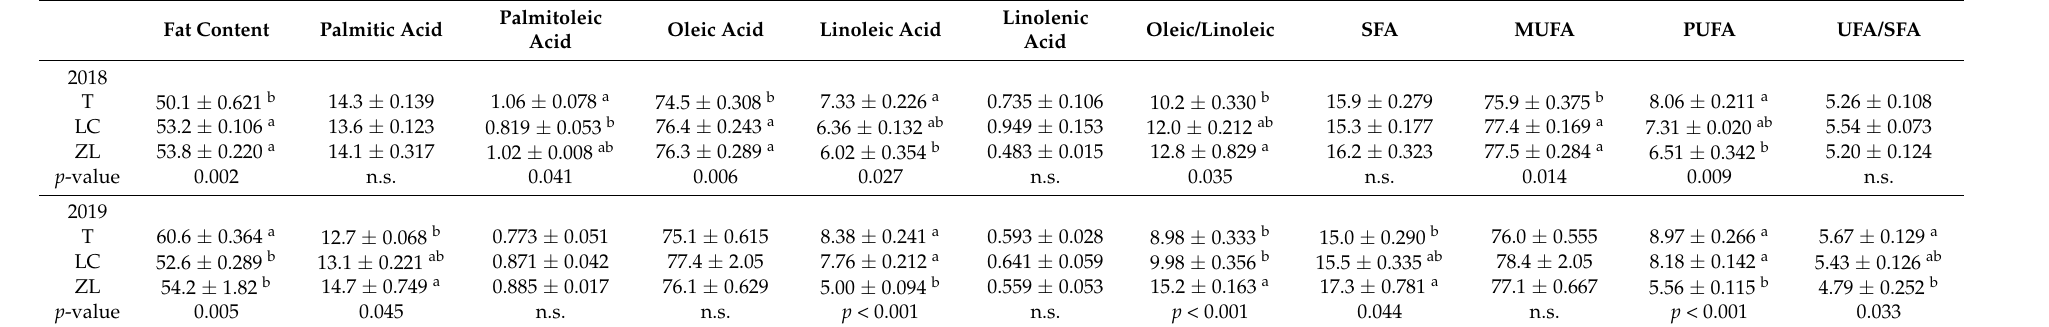
Table 7. Olive fruit fat content (% DW) and fatty acid profile (%) as a function of soil management treatment and harvest year. Fat content, palmitic acid